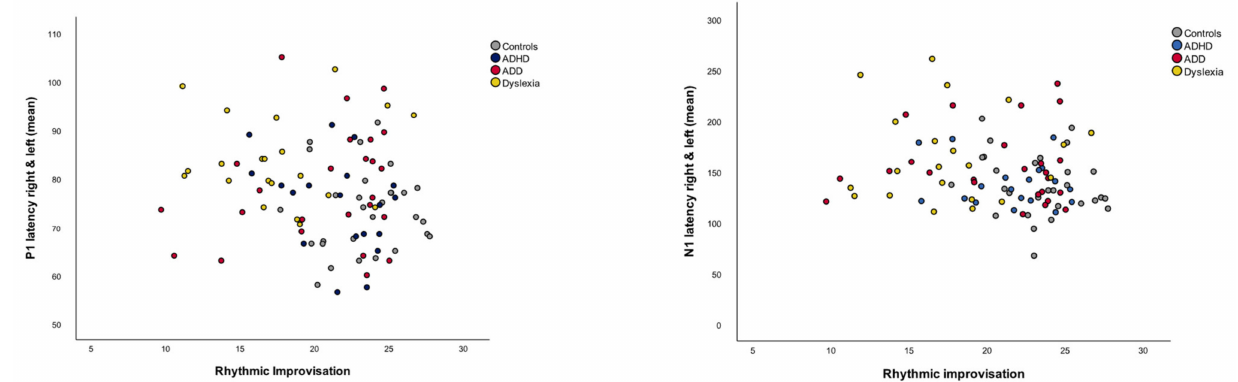
Figure 5. Correlation plots of rhythmic improvisation with P1 latency right and left (mean) and N1 latency right and left (mean). Better rhythmic improvisation is associated with early P1 and N1 latencies (mean). Both correlations remain significant after Benjamini–Hochberg correction for multiple testing ( p <